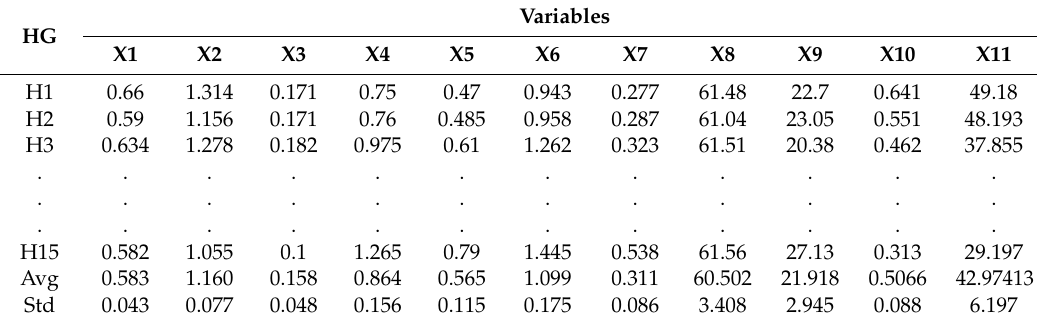
Table 4. Average and standard deviation of the data of the healthy group (HG).